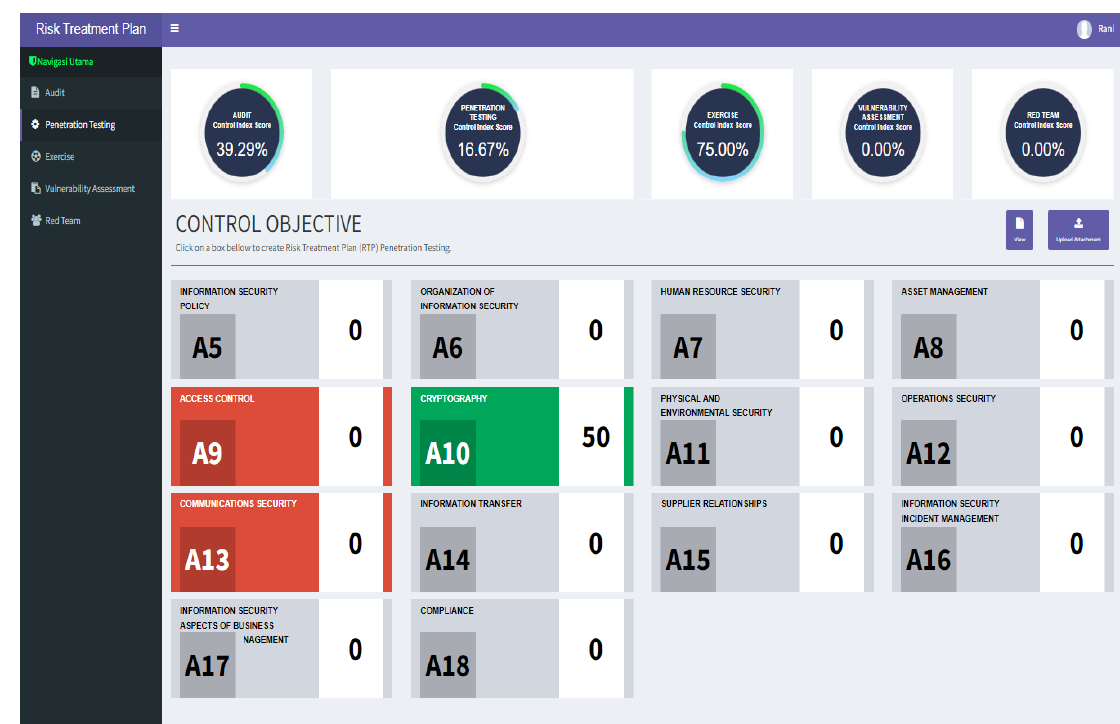
Figure 14. Visual Monitoring of Risk Control Treatment Plan of Penetration Testing Results.